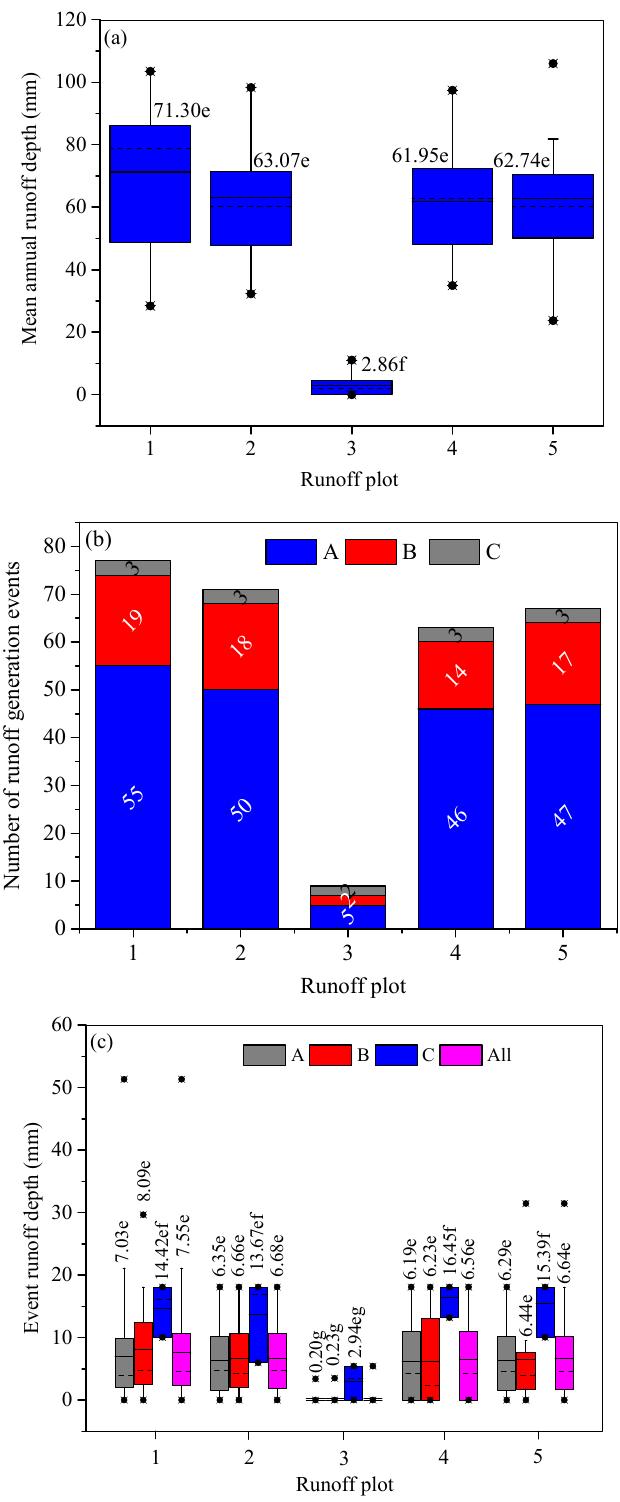
Figure 3. Mean annual runoff depth and standard deviation ( a ); number of runoff generation events induced by rainfall regimes A, B, and C on the five plots ( b ); and mean event runoff depth and standard deviation under each rainfall regime ( c ). Note: Values on the columns with the same letter in ( a , c ) were not significantly different at the 0.05 level. The solid line in the box represents the mean value, and the dotted line represents the median